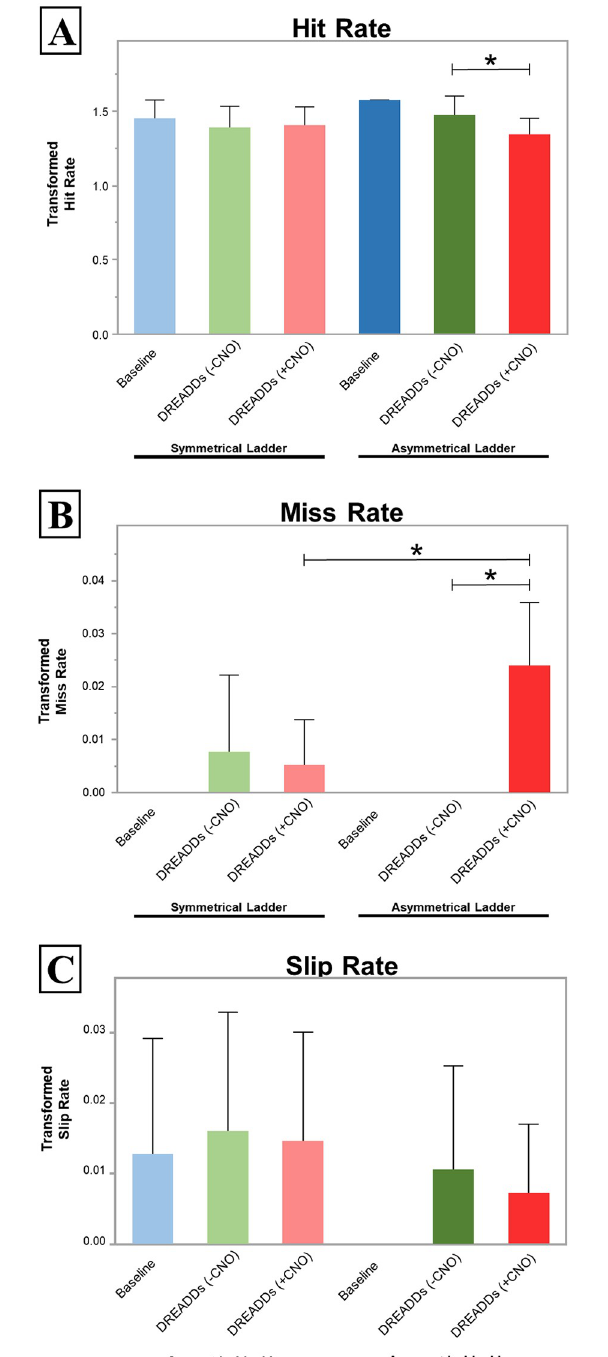
Fig 4. Locomotion data for each ladder type. (A) The arcsine transformed Miss rate of the right hindlimb symmetrical and asymmetrical ladder before DREADDs injections (Baseline), after DREADDs injection (–CNO), and after activation of DREADDs (+CNO). Significance was detected for the intra-ladder comparison between -CNO and +CNO conditions for the asymmetrical ladder only (p = 0.049). (B) The arcsine transformed Hit rate under the same conditions. Significance was detected in two conditions; the intra-ladder comparison between -CNO and +CNO conditions for the asymmetrical ladder (p = 0.000011), and the inter-ladder comparison for the +CNO conditions of the symmetrical and asymmetrical ladder (p = 0.0022). (C) The arcsine transformed Slip rate under the same conditions. We found no significant differences in percent Slip between any two conditions in either the